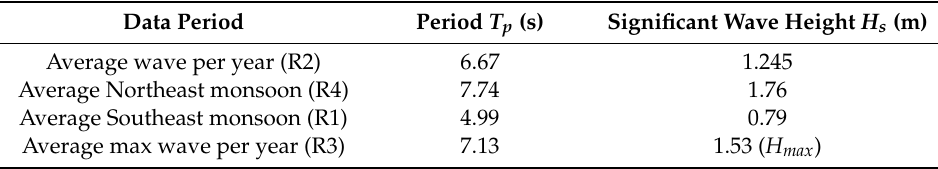
Table 3. Statistical average of wave data according to